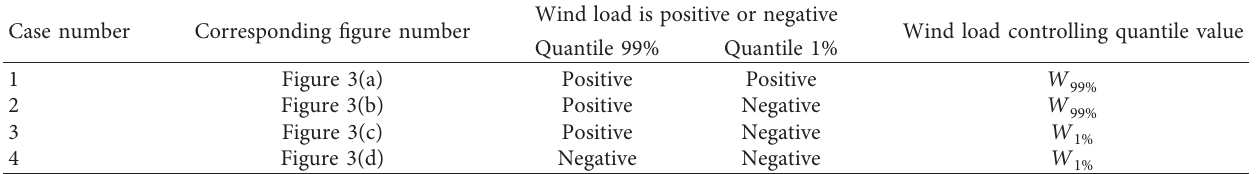
. (c) Illustration of design extreme wind pressure controlled by W 99% . 1% Table 1: Quantile value in different